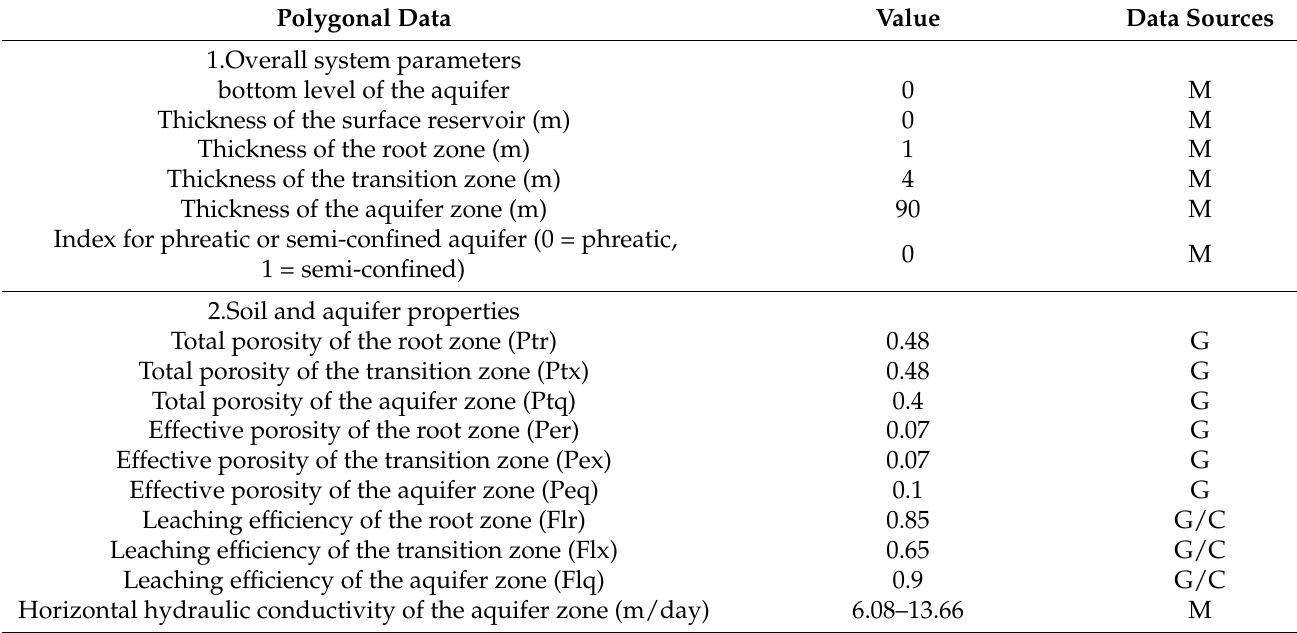
Table 2. Summary of input parameters required by